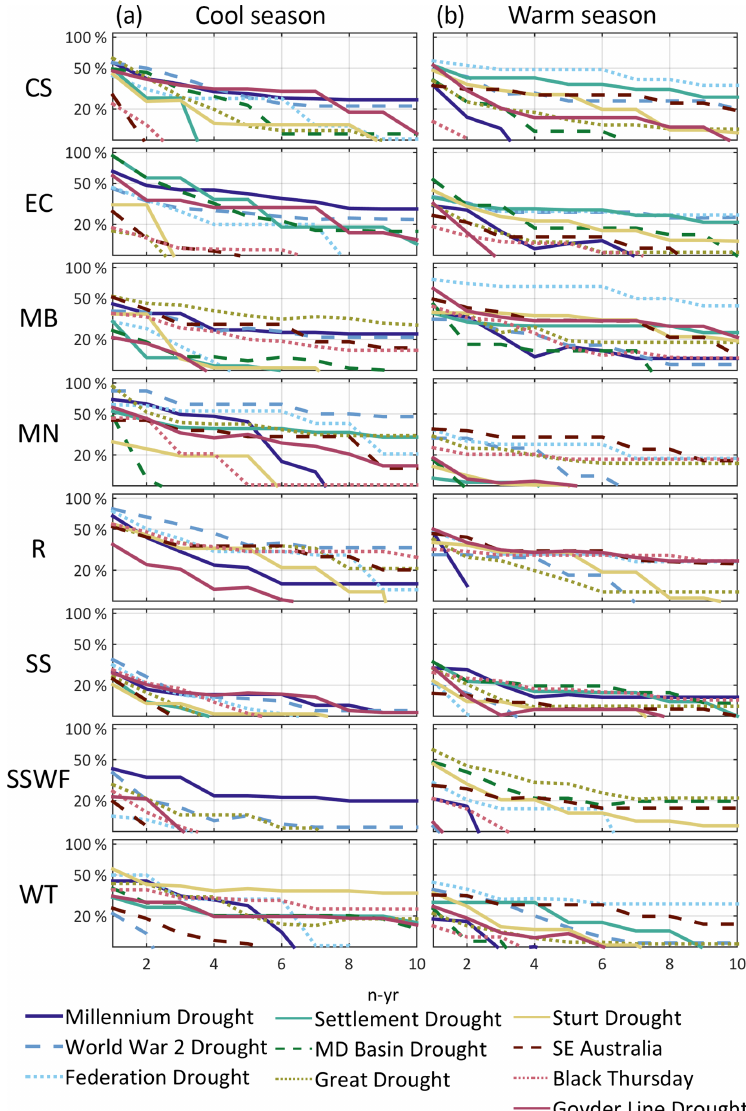
Figure 8. Rainfall drought depth duration percentages across the regions. The percentage reduction below the long-term average of the driest years of variable duration (1–10 years) within the selected drought periods, for the cool season (a) and warm season (b)